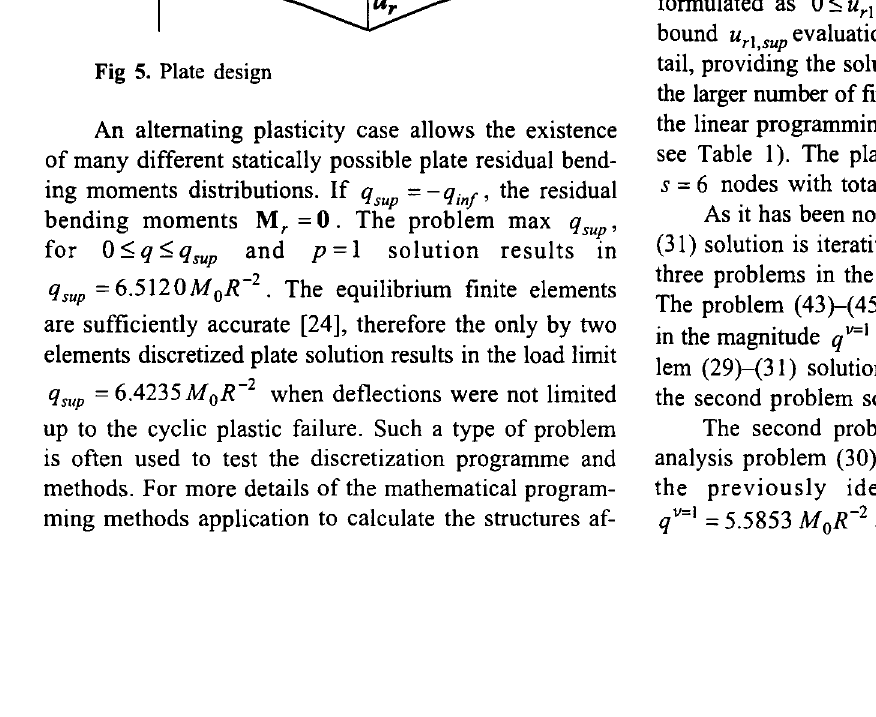
Fig 4. Solution algorithm of the problem